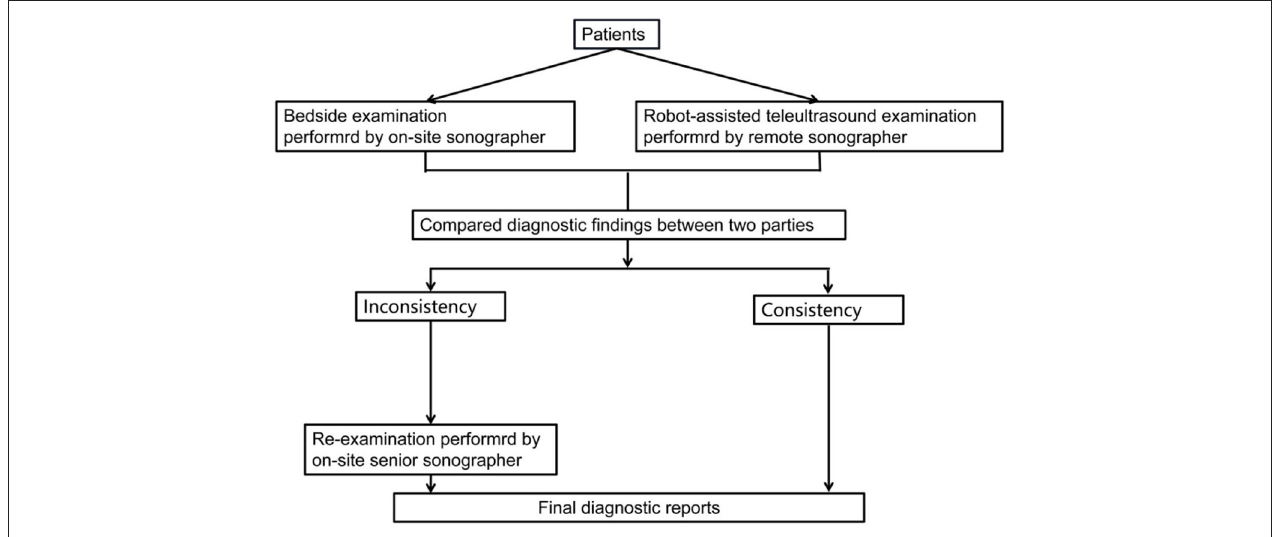
FIGURE 3 | Design of the ultrasound examinations in this